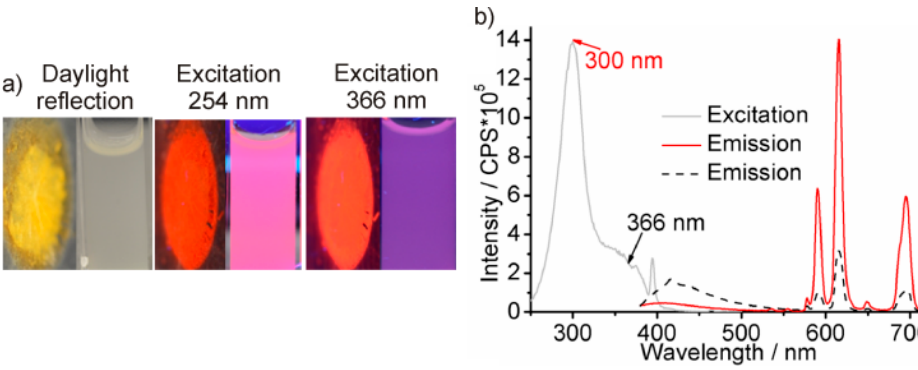
Figure 5. Fluorescence of MW-heated Eu 3+ -modified C-dots: ( a ) photos of powder samples and aqueous suspension (under daylight and under excitation); and ( b ) excitation ( λ em = 615 nm) and emission (red line: λ exc = 300 nm; black dash: λ exc = 366 nm) spectra of aqueous suspensions.